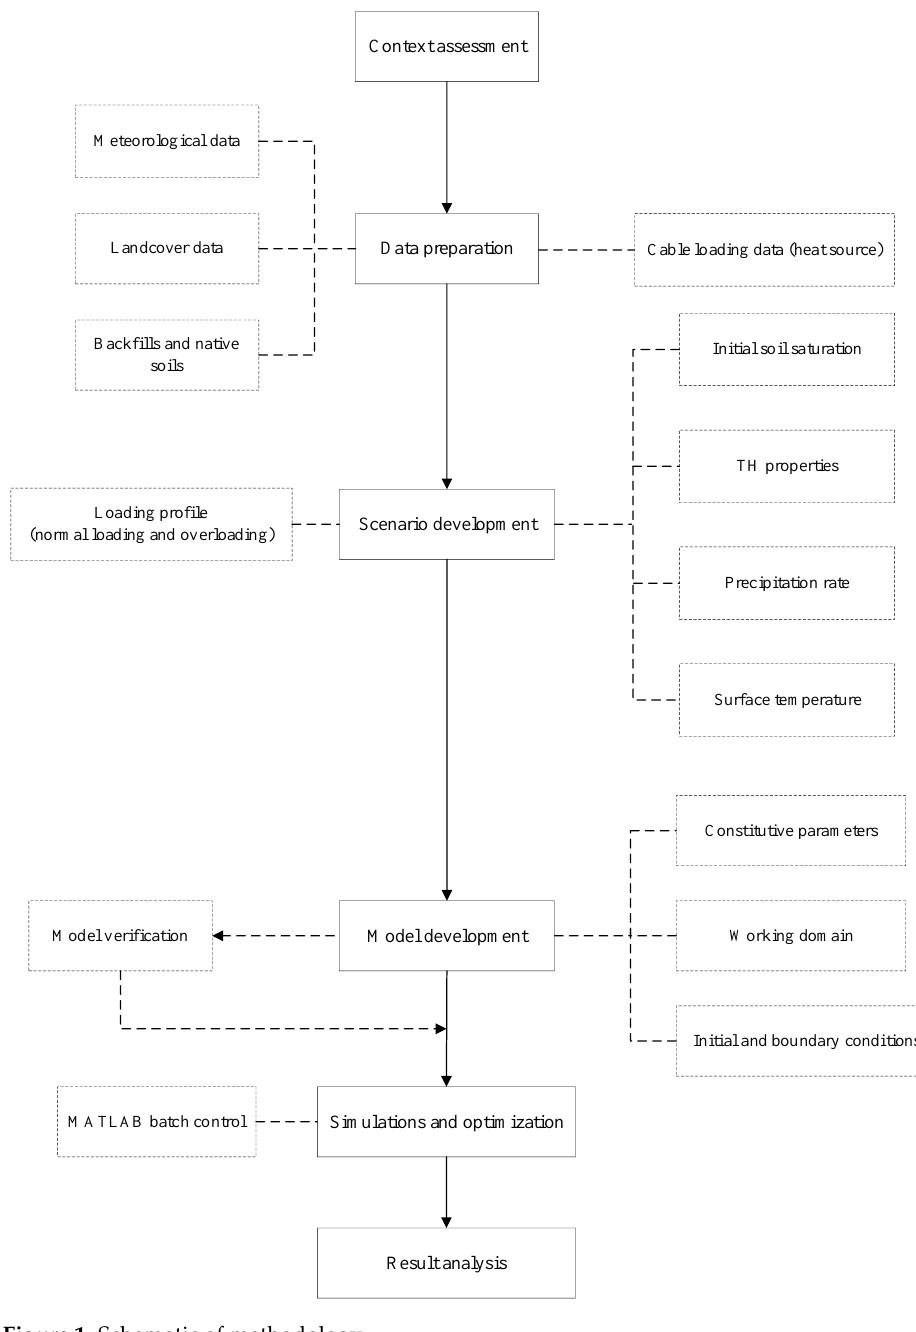
Figure 1. Schematic of methodology.